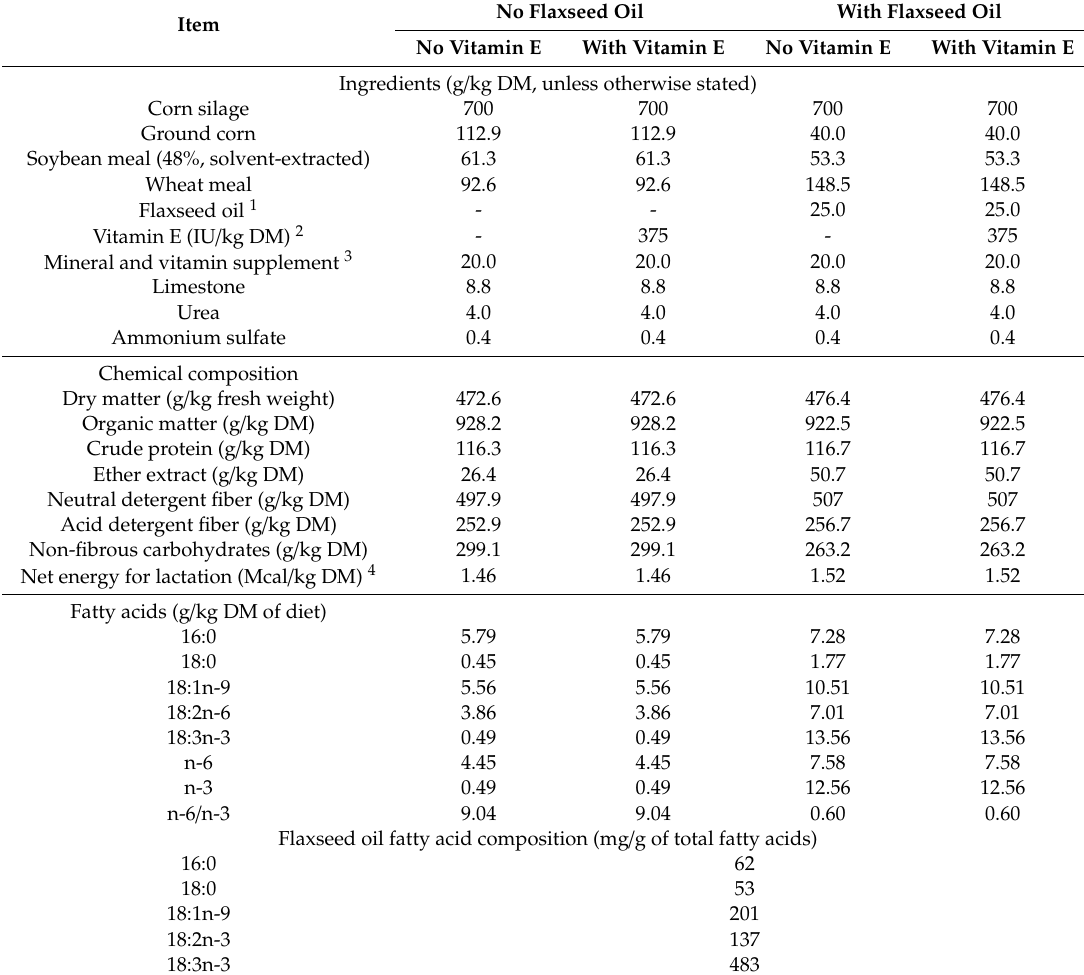
Table 1. Ingredient and chemical composition of the experimental